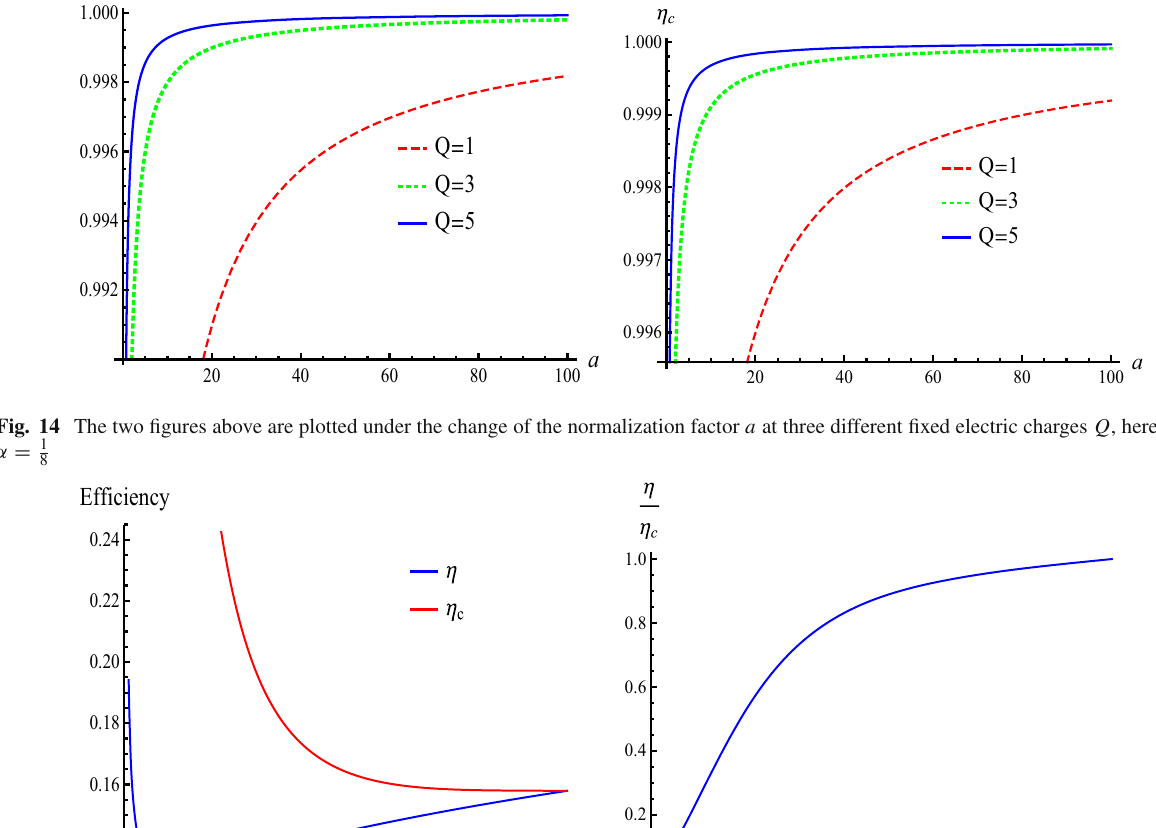
Fig. 15 The behavior of the efficiency η , the Carnot efficiency η c and the ratio η η Figure 15 demonstrates the behavior of the efficiency and the ratio η/η c under the change of α . There is a problem